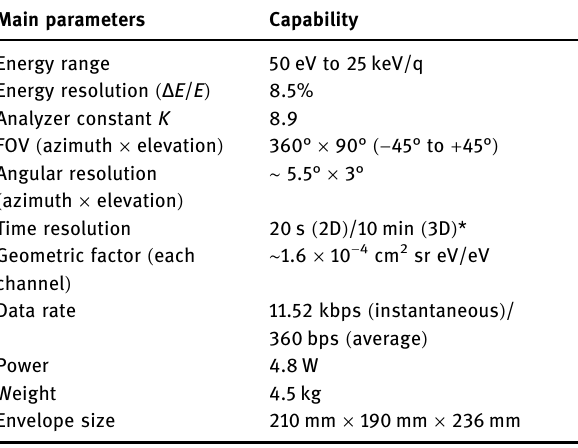
Table 1: Speci fi cations of the LEIS payload Main